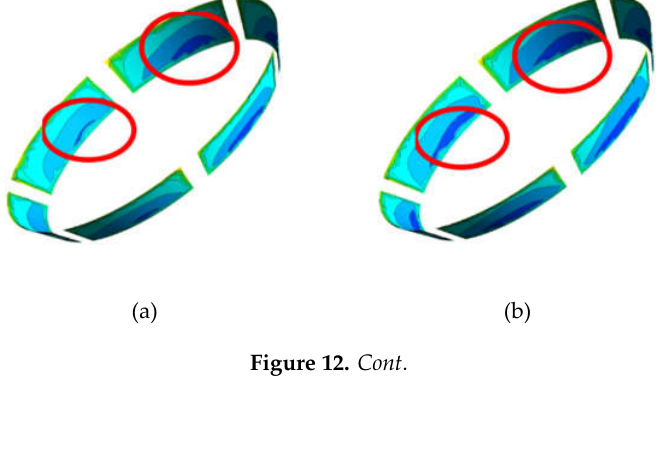
Figure 11. Total pressure contour of second-stage impeller, ( a ) 0.3 mm, ( b ) 0.6 mm, ( c ) 0.9 mm, ( d ) 1.2 mm.